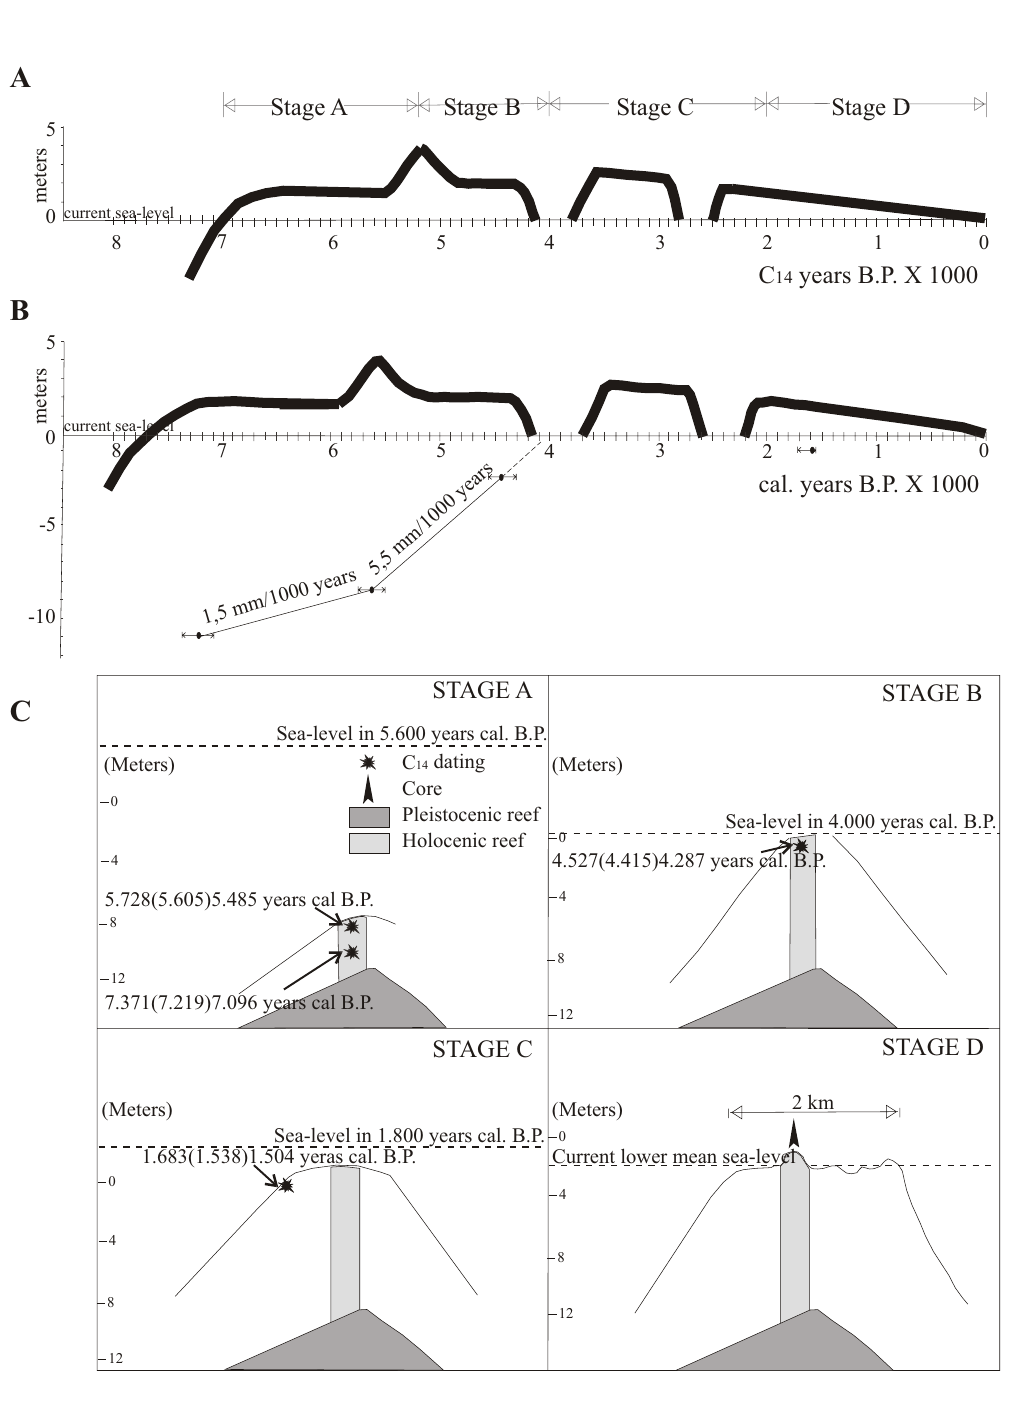
Fig. 4 – Coral reef evolutionary model based on radiocarbon ages and accumulation rates determined for the Coroa Vermelha reef: A – Coral reef development stages plotted on the Salvador sea-level curve (radiocarbon years) and B – Coral reef development stages plotted on the Salvador sea-level curve (calendar years). In the curve B are also plotted the growth rates of the Coroa Vermelha reefs (Leão and Kikuchi 1999). C – Coral reef development stages: Stage A – initial reef establishment stage, Stage B – rapid vertical accretion, Stage C – rapid lateral growth and Stage D – reef degradation (modified from Leão et al.